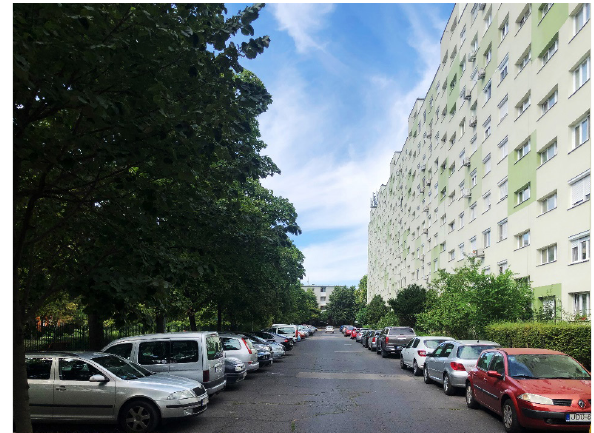
Figure 14. Kelenföld residential courtyard view on the parking